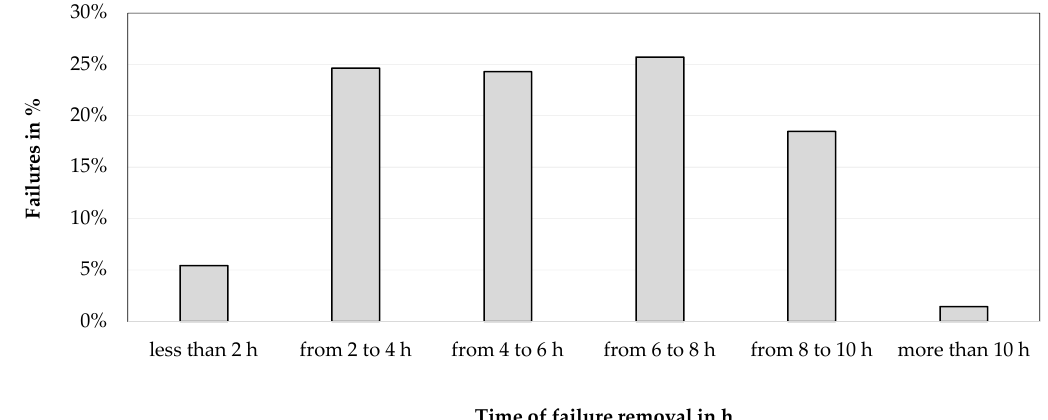
Figure 4. Failure modes classification according to their repair time.